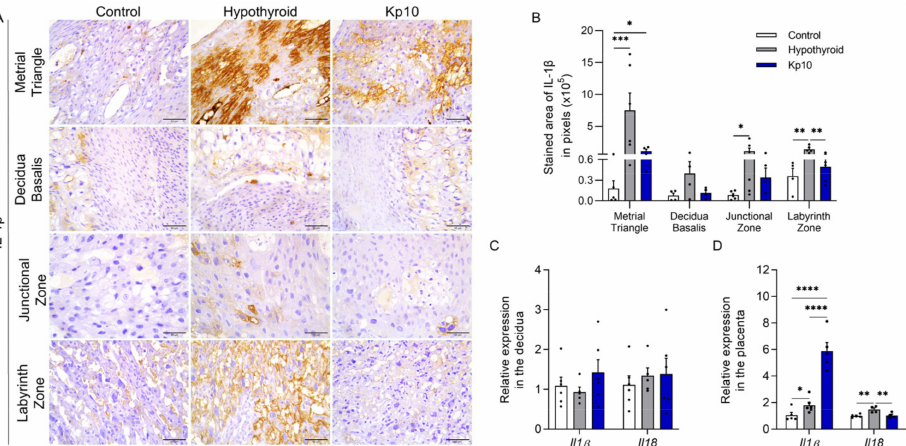
Figure 2. Expressions of IL-1 β and IL-18 at the maternal-fetal interfaces of control, hypothyroid, and kisspeptin-10 (Kp10)-treated rats. ( A ) Photomicrographs of the immunohistochemical expres- sion of IL-1 β at the maternal-fetal interface (streptavidin-biotin-peroxidase; Harris hematoxylin; Bar = 50 µ m). ( B ) Immunostaining areas in pixels of IL-1 β expressions in the metrial triangle, basal decidua, junctional zone, and labyrinth zone (mean ± SEM; n = 8). ( C ) Relative gene expressions of Il1 β and Il18 in the decidua (mean ± SEM; n = 8). ( D ) Relative gene expressions of Il1 β and Il18 in the placenta (mean ± SEM; n = 8). Significant differences were determined by post hoc ANOVA SNK, * p < 0.05, ** p < 0.01, *** p < 0.001, **** p < 0.0001. Kp10 = daily treatment with Kp10; DG = day of